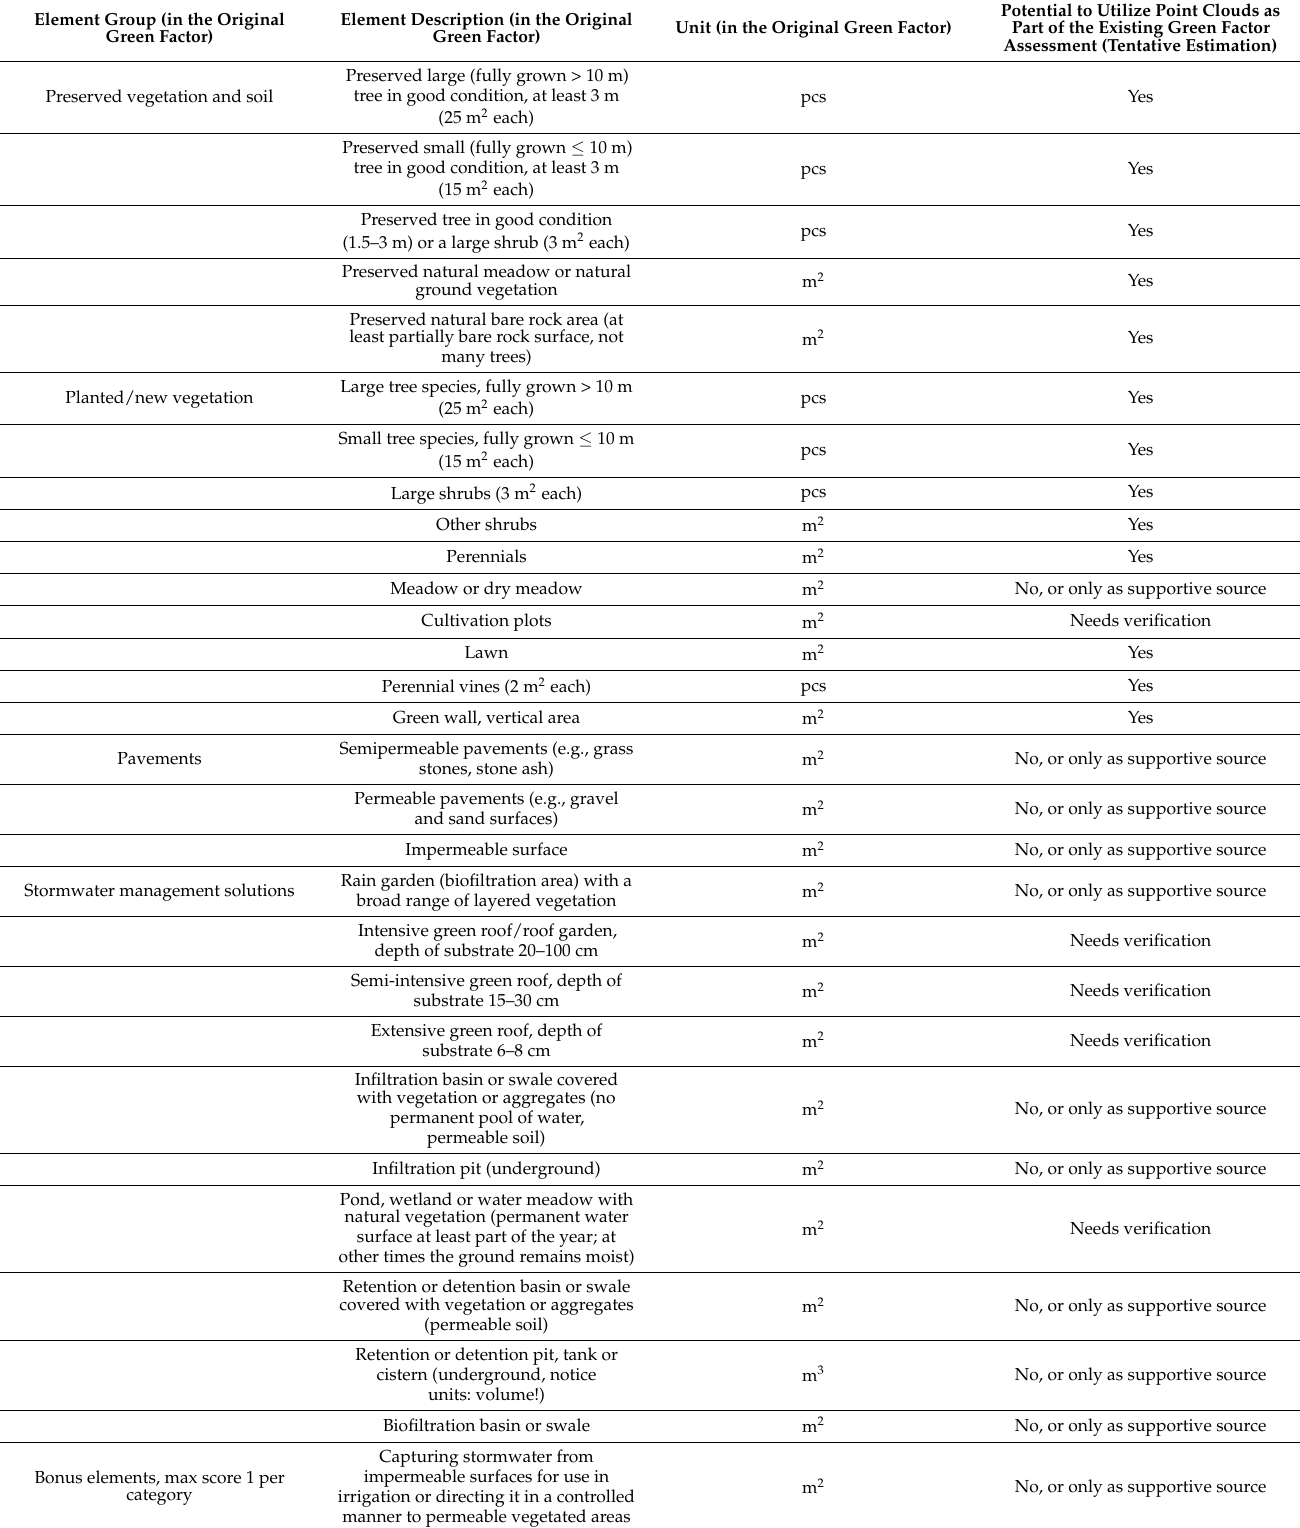
Table A2. Tentative estimation based on the study results; possibility to utilize point clouds in green factor-based assessment of existing